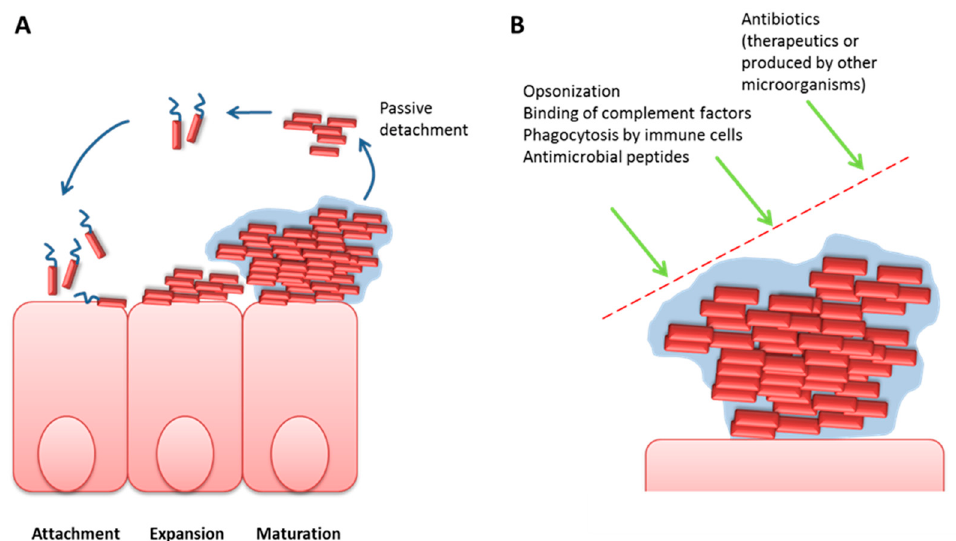
Figure 2. Biofilm formation on a biotic surface and protection against harms. ( A ) Bacterial biofilms form in three main steps: after initial attachment, bacteria expand and start to produce specialized components such as cellulose [45] to form a protective “slime” along with forfeiting motility. In a later phase, the mature biofilm allows detachment of clumps of cells or newly built cells to translocate to new areas of settling. Pore-building by PSMs (see Table 2) is assumed to play a major role in these events. ( B ) While one can imagine the biofilm to provide an ecosystem with restricted access to nutrition and space, it in contrast provides an especially protected area against attacks of the host immune system but also against exogenously added drugs or toxic compounds of other microbial